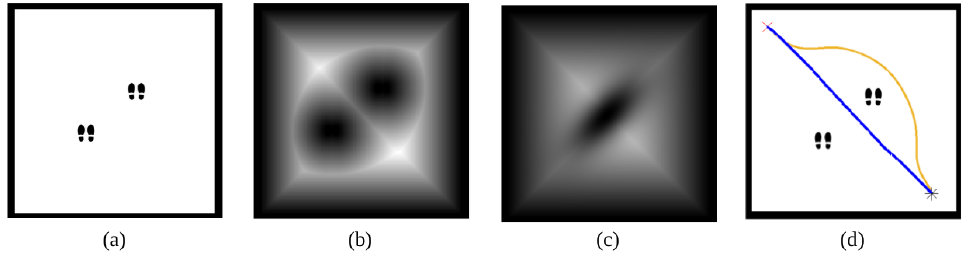
Figure 17. Advantages of using the proposed Gaussian model method. For the environment pre- sented in ( a ), the velocity map F is extracted, interpreting humans as objects ( b ) and as a group ( c ). When the path planner is applied ( d ), the calculated path goes between the two individuals in the first case (blue line), whereas for the second case, the social space is respected (orange